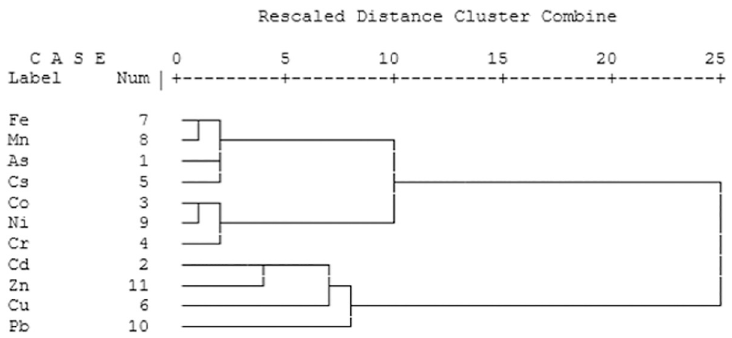
Fig 3. Dendrograms of cluster analysis for heavy metals from Yazd